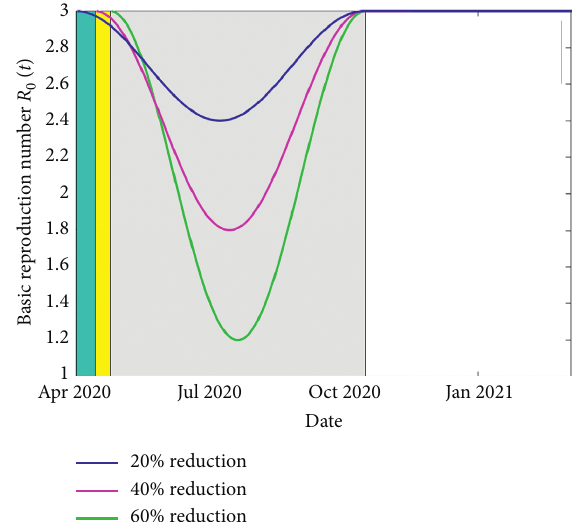
Figure 4: Depiction of the effects of school closedown, curfew, and partial lockdown on the time-dependent basic reproduction number. The duration of school closedown, of 210 days, is indicated by the cyan color. However, it is overlapped by the duration of curfew implementation, shown here in yellow. The yellow region is in turn overlapped by the gray region which represents the duration of partial lockdown implementation.